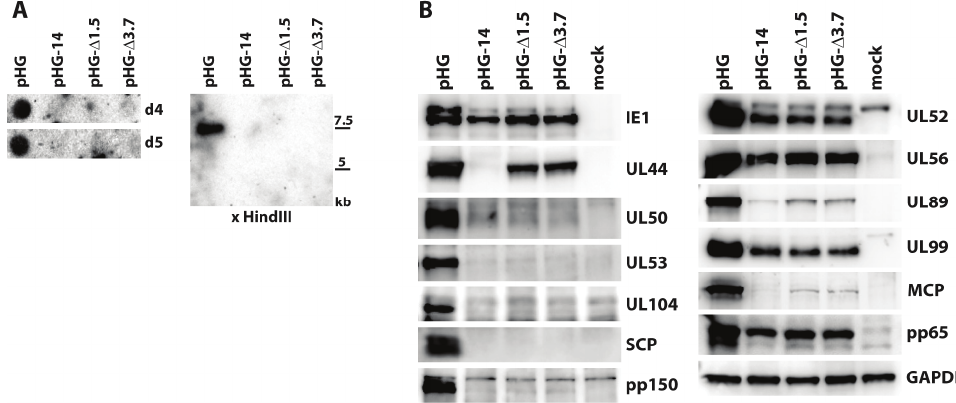
Figure 3. Analysis of viral genome replication and protein expression in adenofected